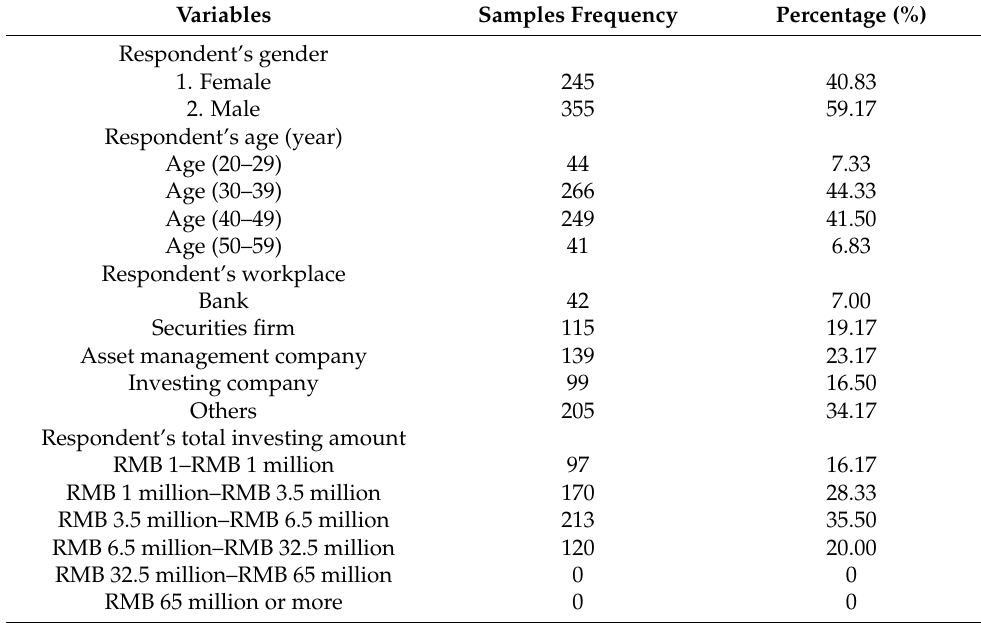
Table 2. Demographic statistics of survey respondents ( n = 600). Variables Samples Frequency Percentage